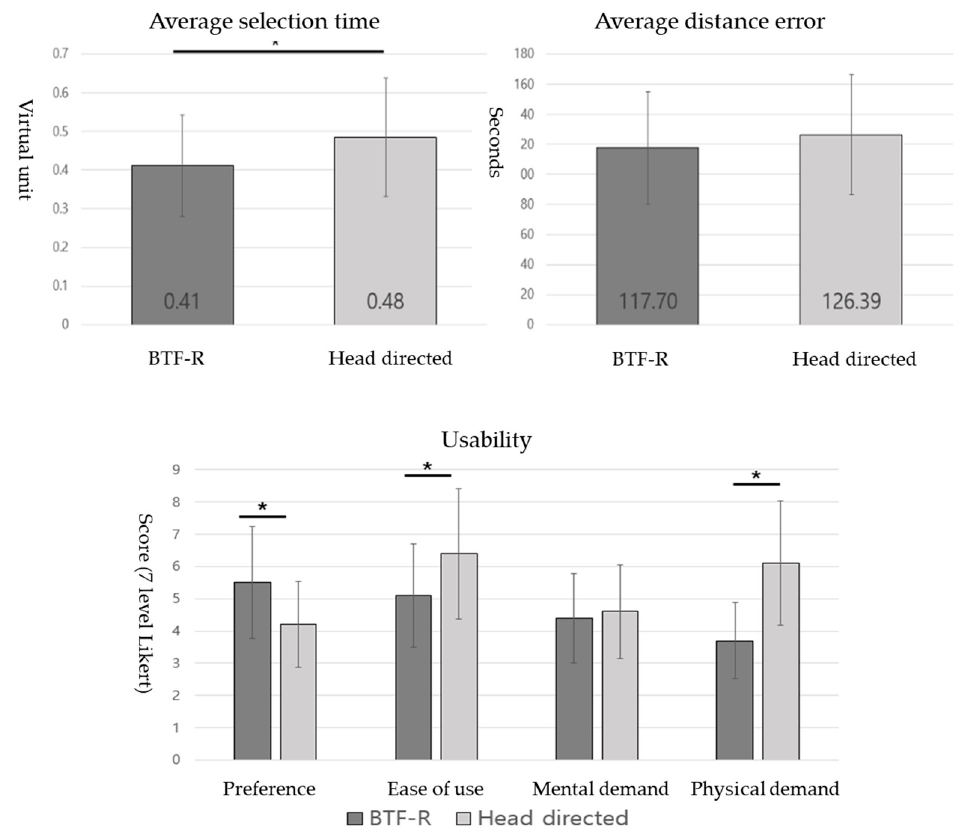
Figure 5. Selection performance (above) and usability (below) between BTF-R and head-directed methods. Note that higher score means more positive toward usability for the categories of preference and ease of use, and vice versa for mental and physical demand. The asterisk mark (*) indicates statistically significant difference.